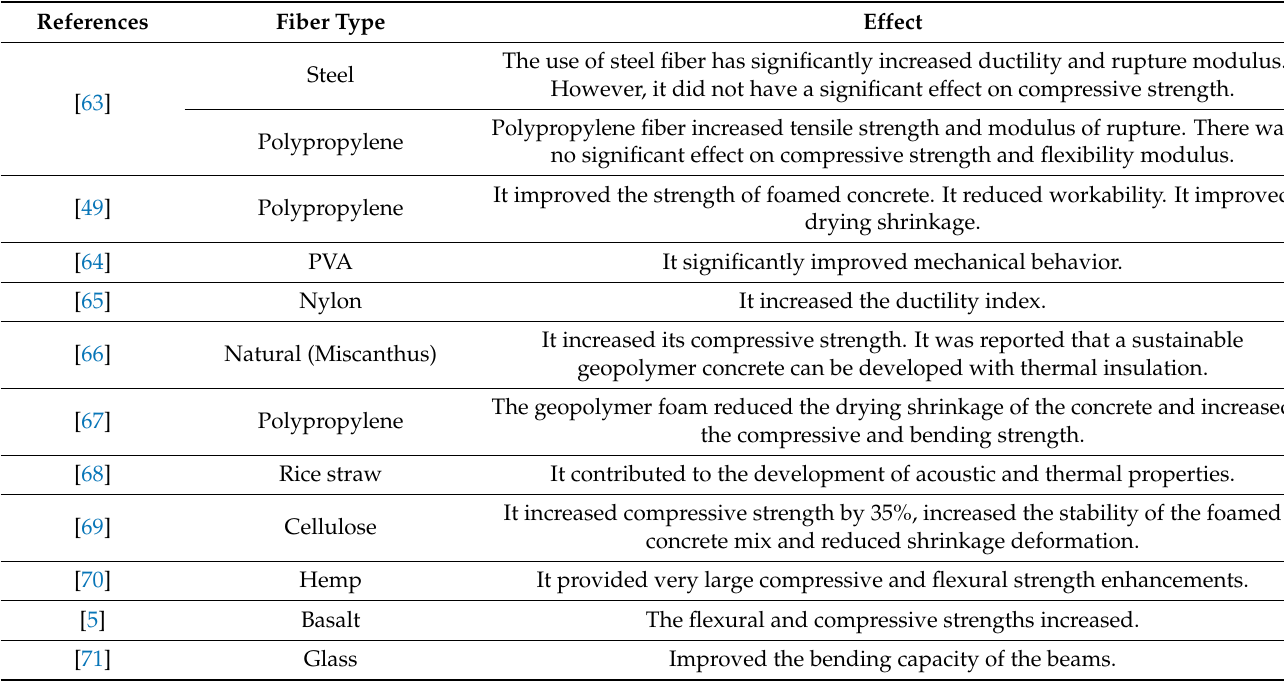
Table 3. Some examples of fiber reinforced foam concrete